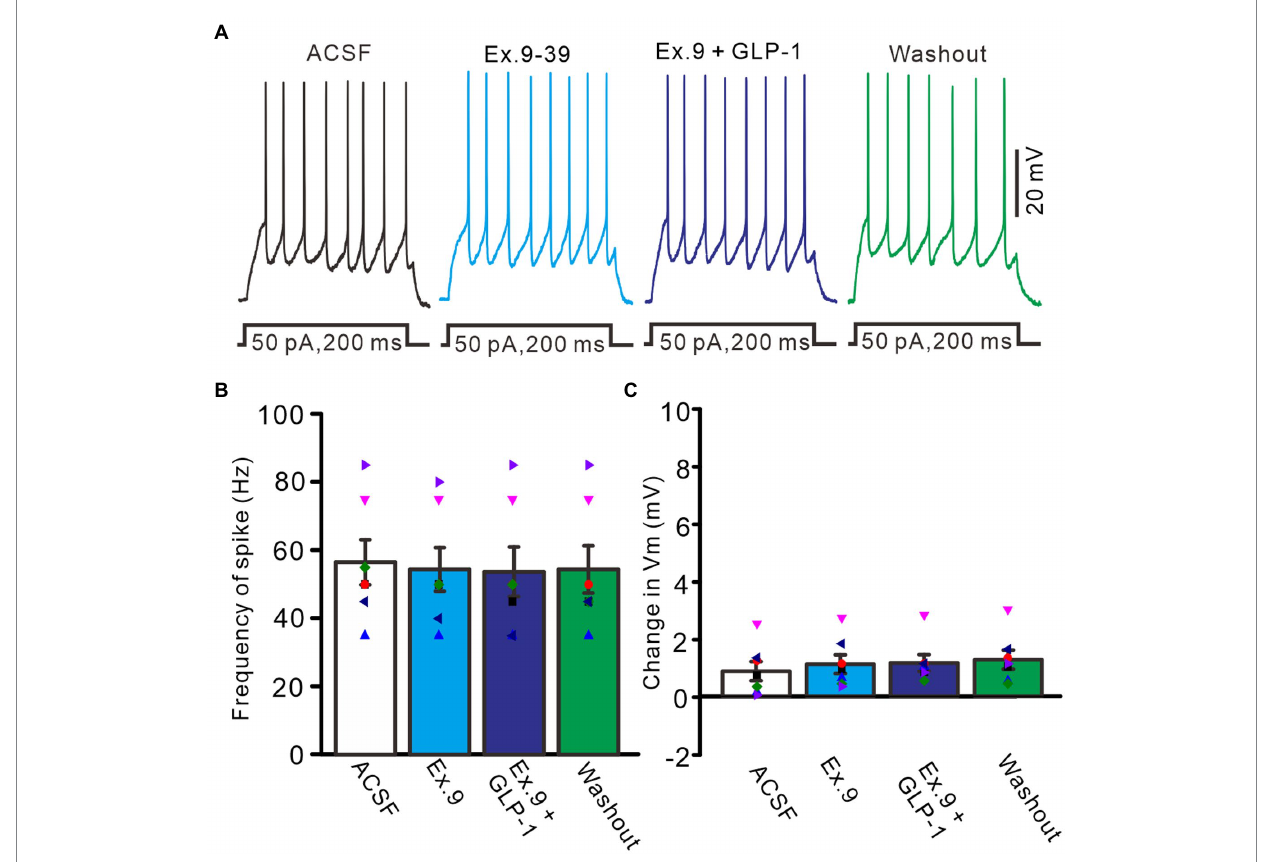
FIGURE 3 Blockade of GLP-1 receptor, GLP-1 failed to enhance the excitability of PCs. (A) Under current-clamp recording mode (Vm = − 80 mV), the representative traces showing PCs in response to depolarization currents (50 pA, 200 ms) during treatments with ACSF, GLP-1 (100 nM), Exendin-39 (Ex. 39; 100 nM), Exendin-39 + GLP-1 (100 nM) and washout. (B) The mean (± S.E.M) with individual data showing the number of spikes evoked by depolarization current during treatments with ACSF, Exendin-39 (Ex. 39), Exendin-39 + GLP-1 and washout. (C) The mean (± S.E.M) with individual data showing the change of resting membrane potential during treatments with ACSF, Exendin-39 (Ex. 39), Exendin-39 + GLP-1 and